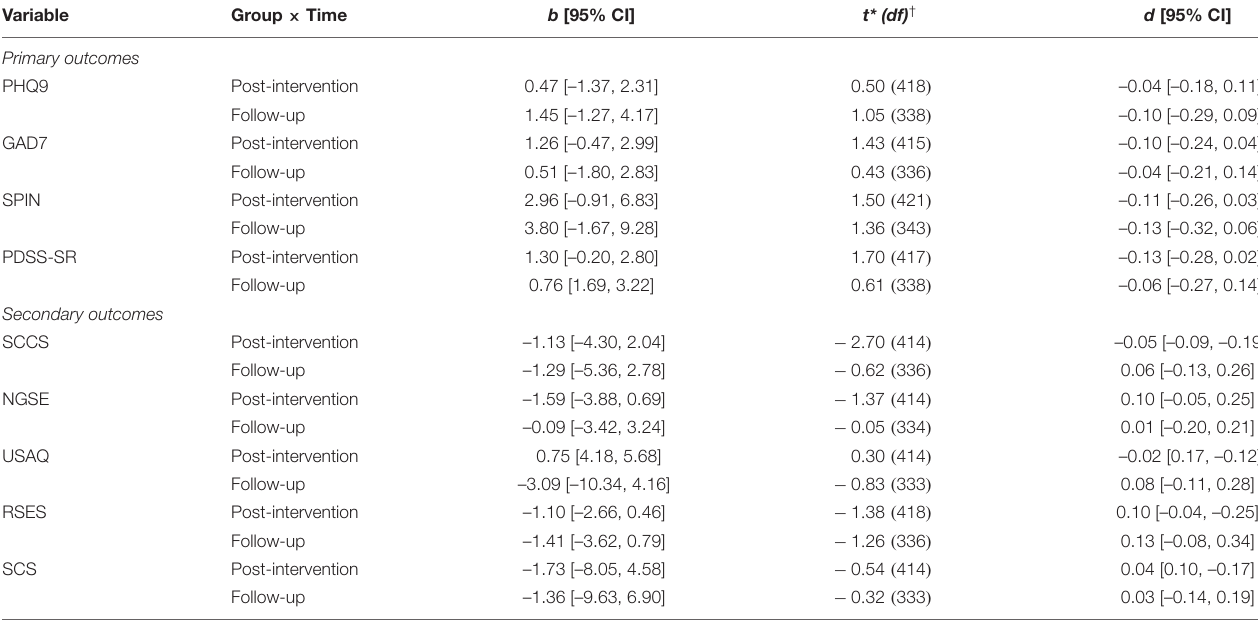
TABLE 3 | Estimated differences in mean change between baseline and post intervention, respectively, follow-up, for the intervention versus the control group (group by time interactions). Variable Group ×